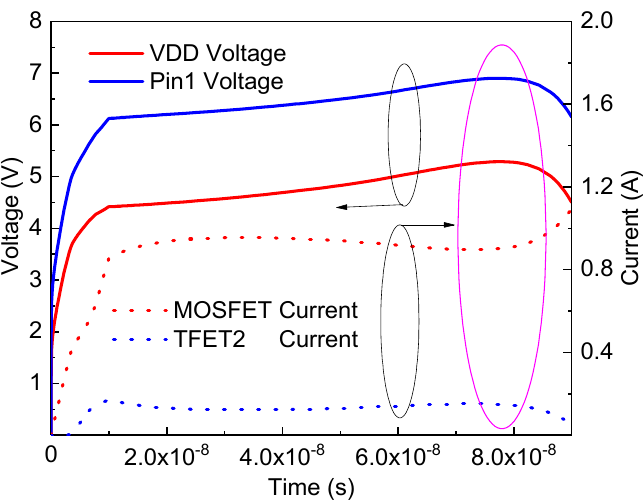
Figure 10. Transmission line pulse response of the SiGe-source TFET-based ESD network.